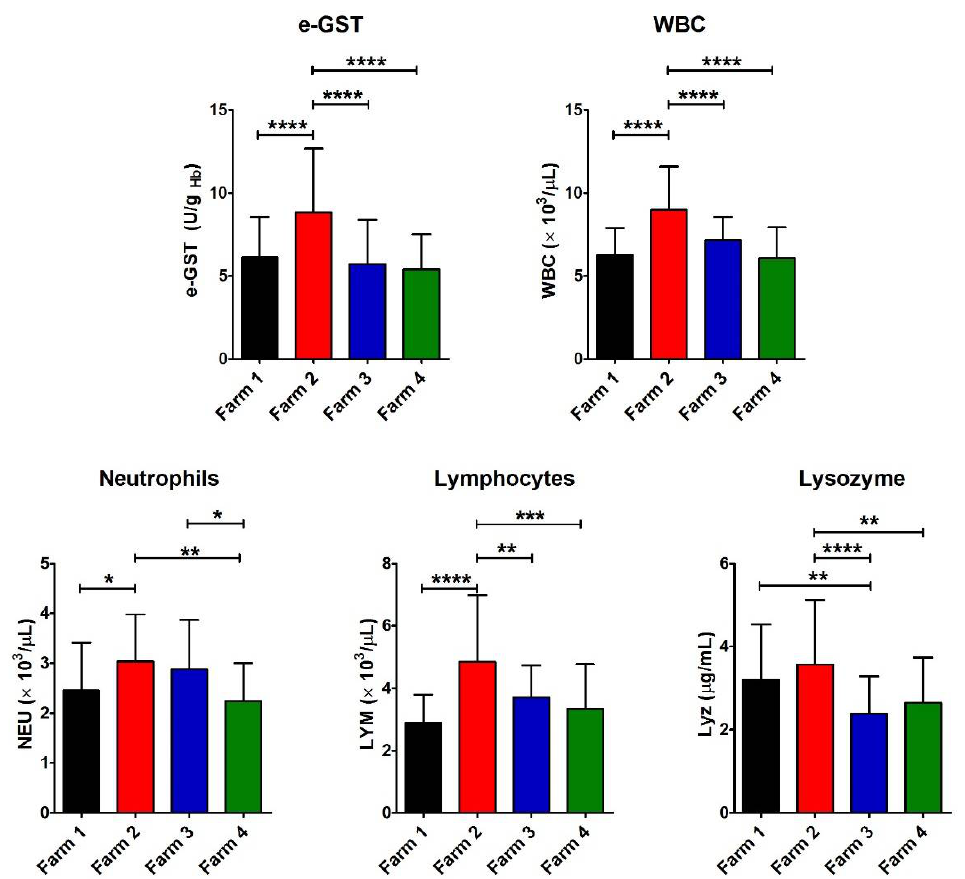
Figure 2. Values of e-GST, immune response, and infection biomarkers. Histograms show the average for the eight parameters measured for each farm (Farm 1–4). The error bars represent the standard deviations. At the top of the columns, the asterisks represent the P values (see Materials and Methods) ( p ≤ 0.05 (*), p ≤ 0.01 (**), p ≤ 0.001 (***), and p ≤ 0.0001 (****)).